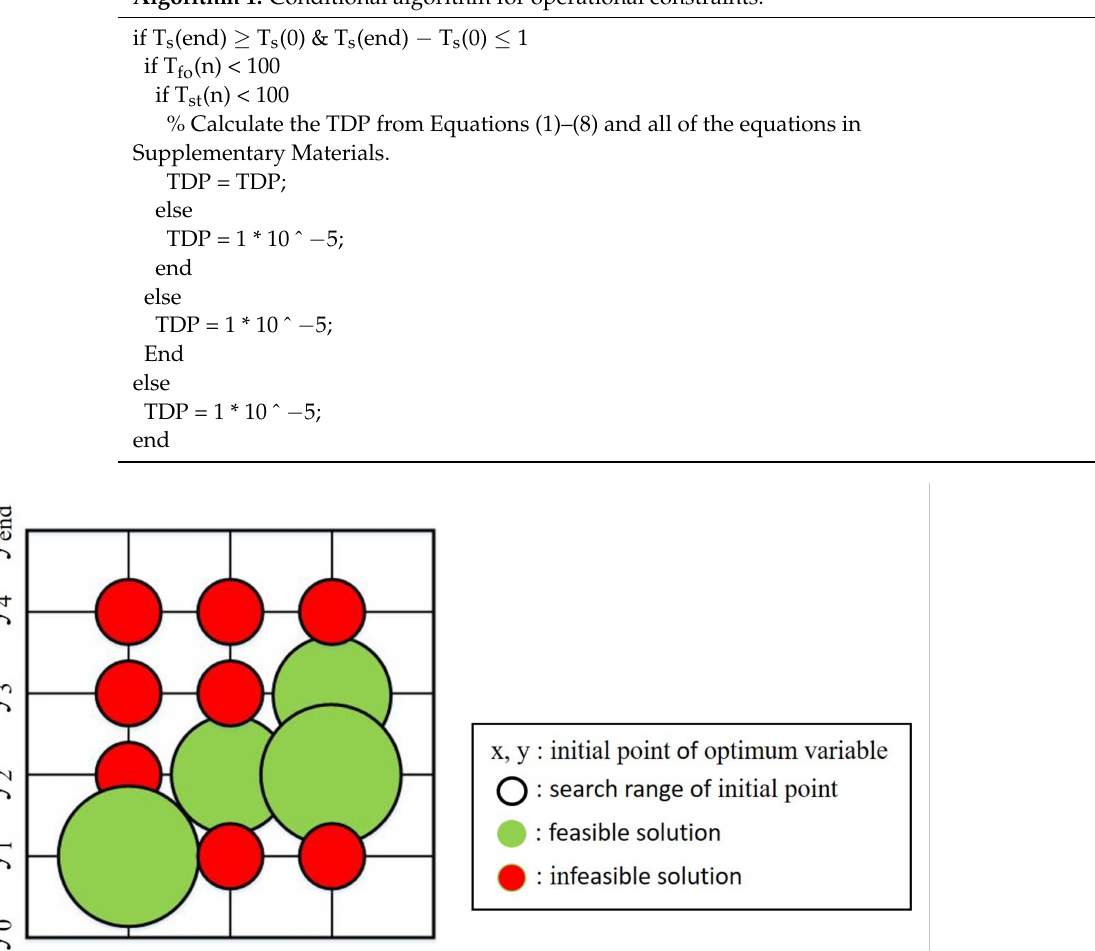
Algorithm 1. Conditional algorithm for operational constraints.